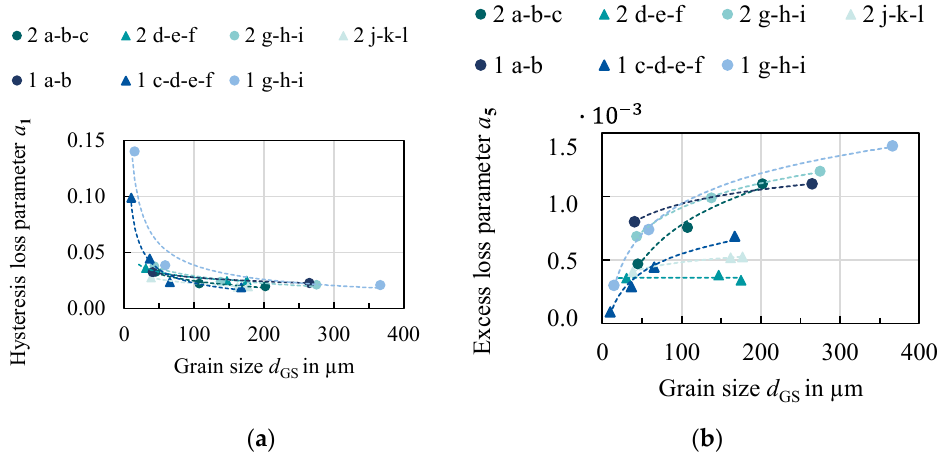
Figure 8. Loss parameters identified for the IEM model for all studied materials: ( a ) hysteresis loss parameter; ( b ) excess-loss parameter. Triangles and squares represent 0.25 mm and 0.5 mm, respectively.